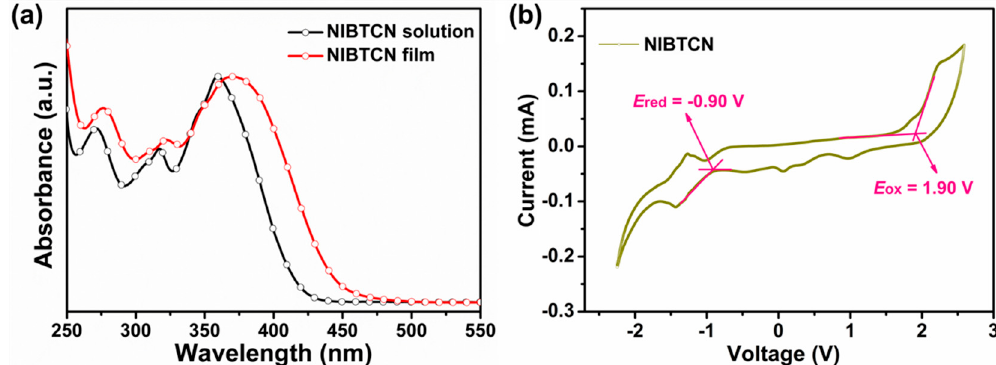
Figure 1. ( a ) UV/Vis absorption spectra of NIBTCN in solution and as thin film on a quartz plate. ( b ) Cyclic voltammetry of NIBTCN accompanied with redox peaks.